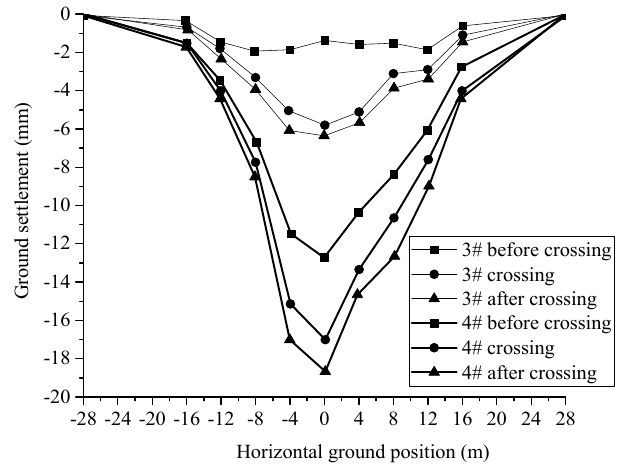
Figure 7. Horizontal ground settlement under the condition of first-down and then-up crossing.